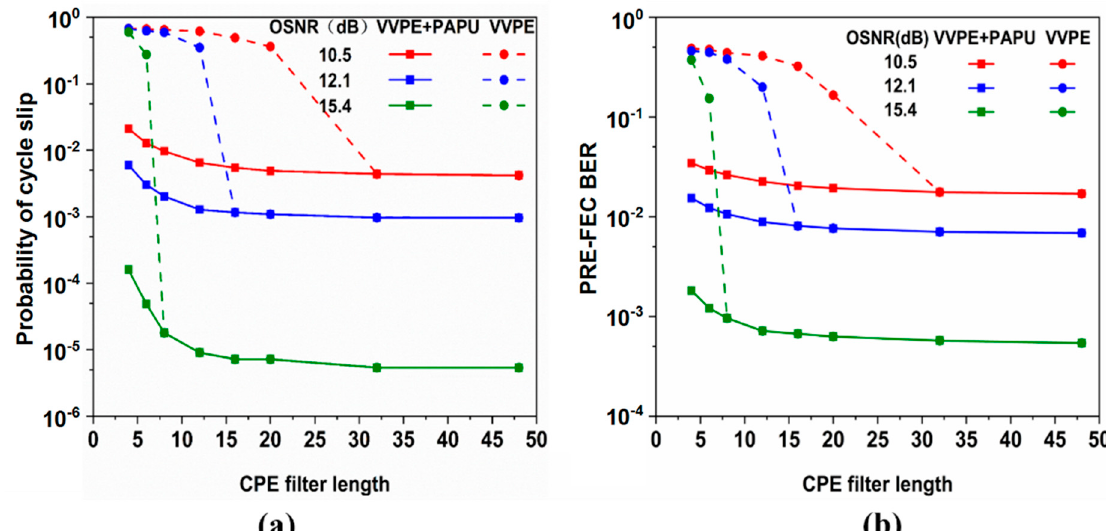
Figure 5. ( a ) Probability of cycle slips versus CPE filter length for the CPE scheme and the CPE + PAPU scheme; ( b ) PRE-FEC BER versus CPE filter length for the CPE scheme and the CPE + PAPU scheme, with OSNR equivalent to 10.5 dB, 12.1 dB, and 15.4 dB.